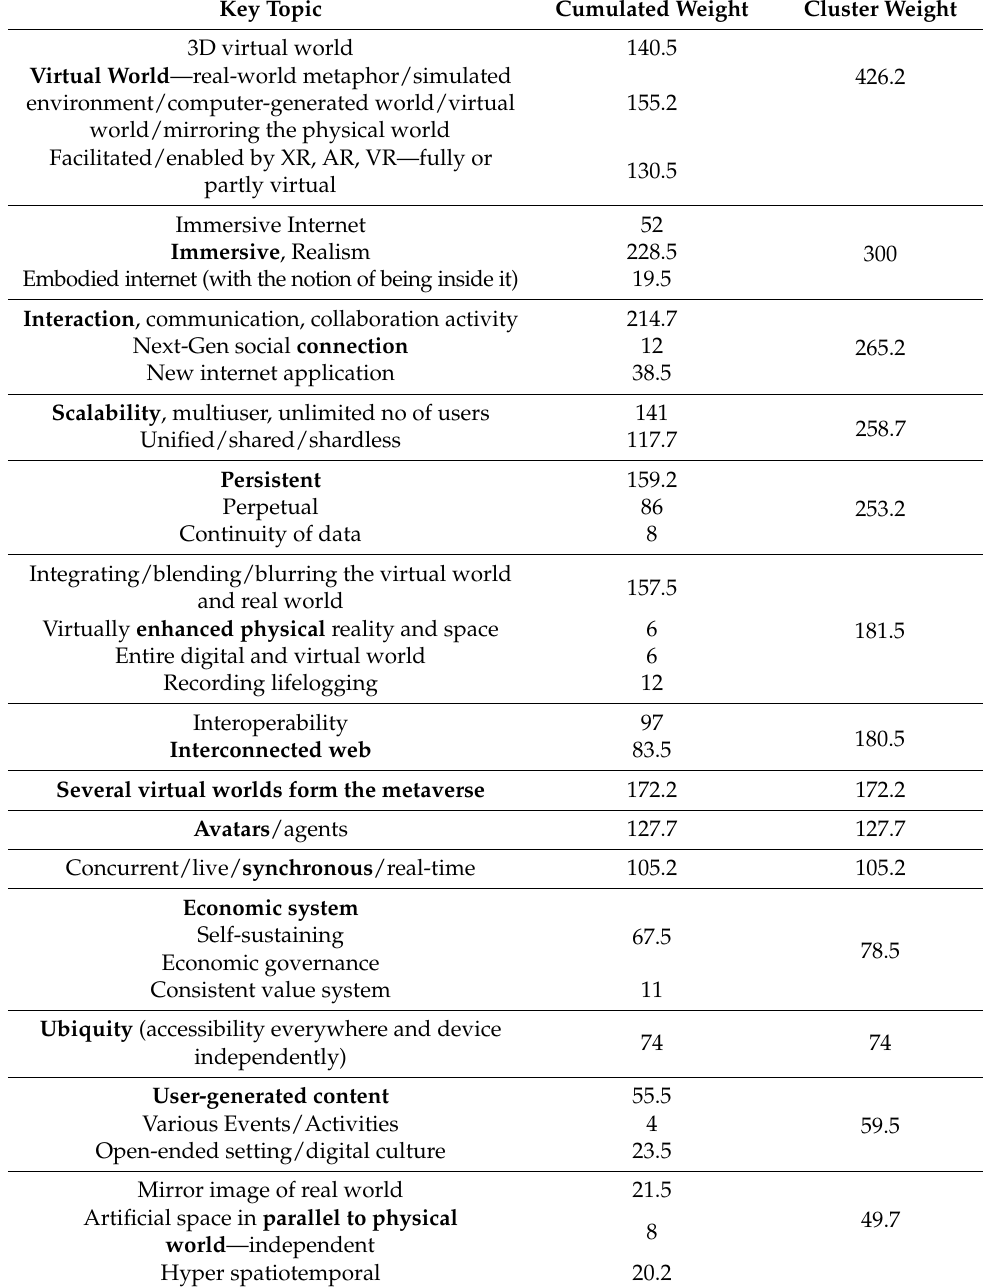
Table 3. Results after clustering key topics and sorting for the cluster